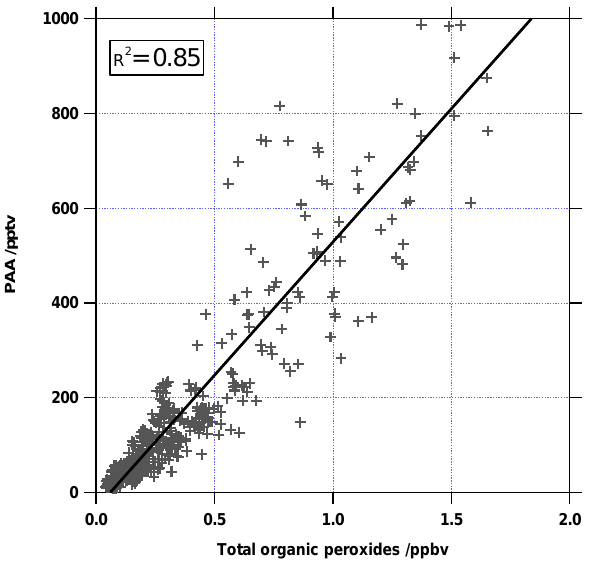
Fig. 5. Scatter plot of ICIMS PAA versus total organic peroxides for the whole